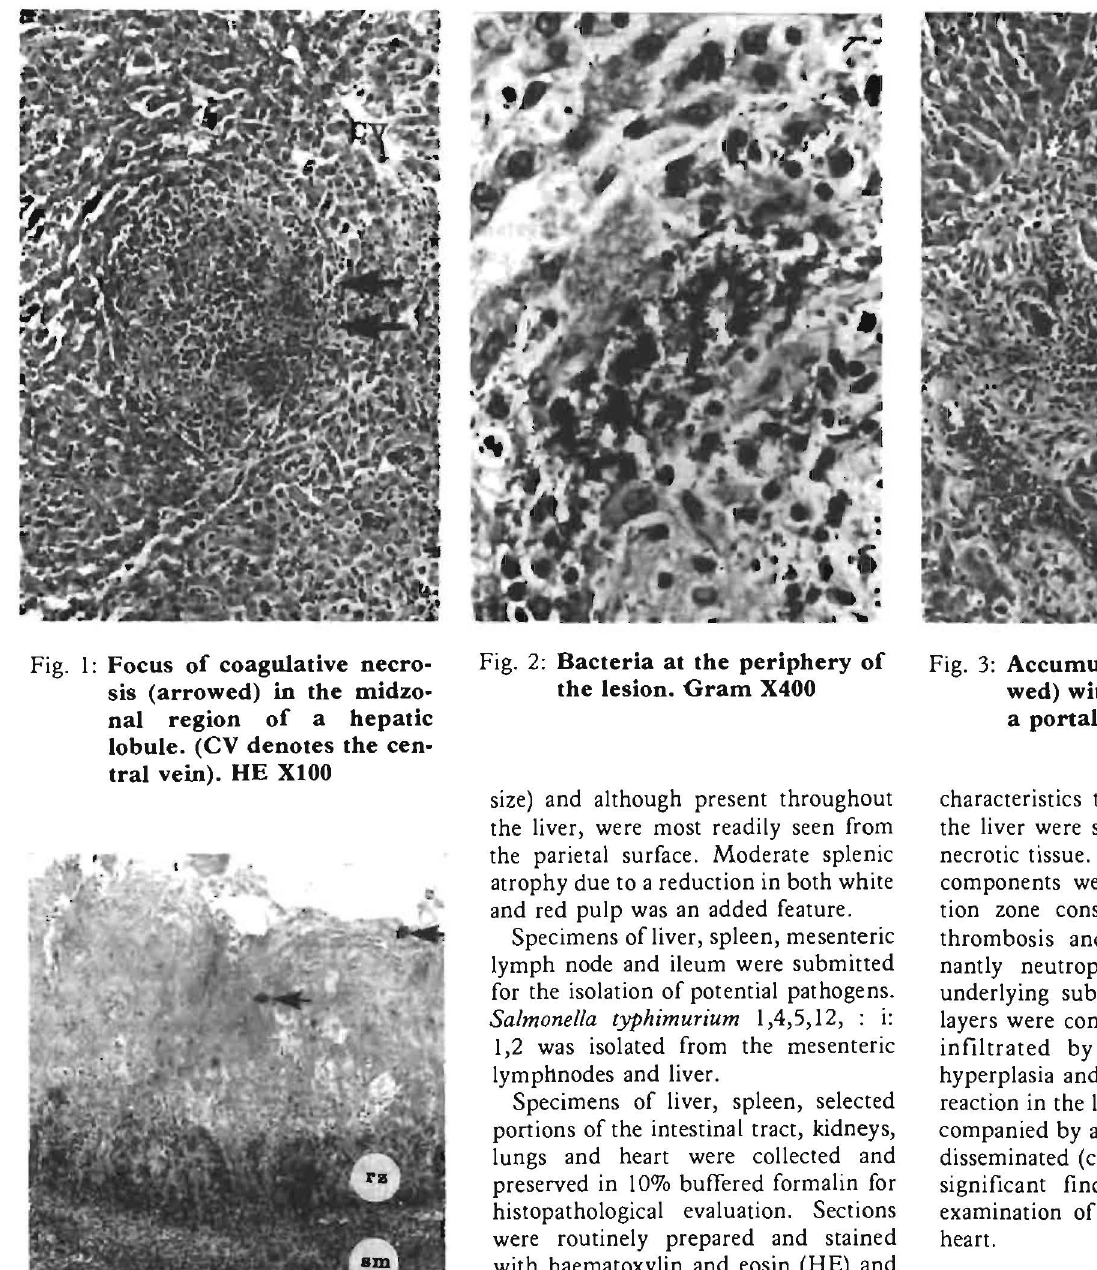
Fig. 4: Diphtheritic enteritis. Note (I) the necrotic pseudomem brane (top) containing colo nies of bacteria (arrowed) separated from the viable tissue by a reaction zone (RZ) and (2) the congestion, oedema and leukocytic inm tration of the submucosa (SM). (M denotes the circu lar muscle layer). HE X40